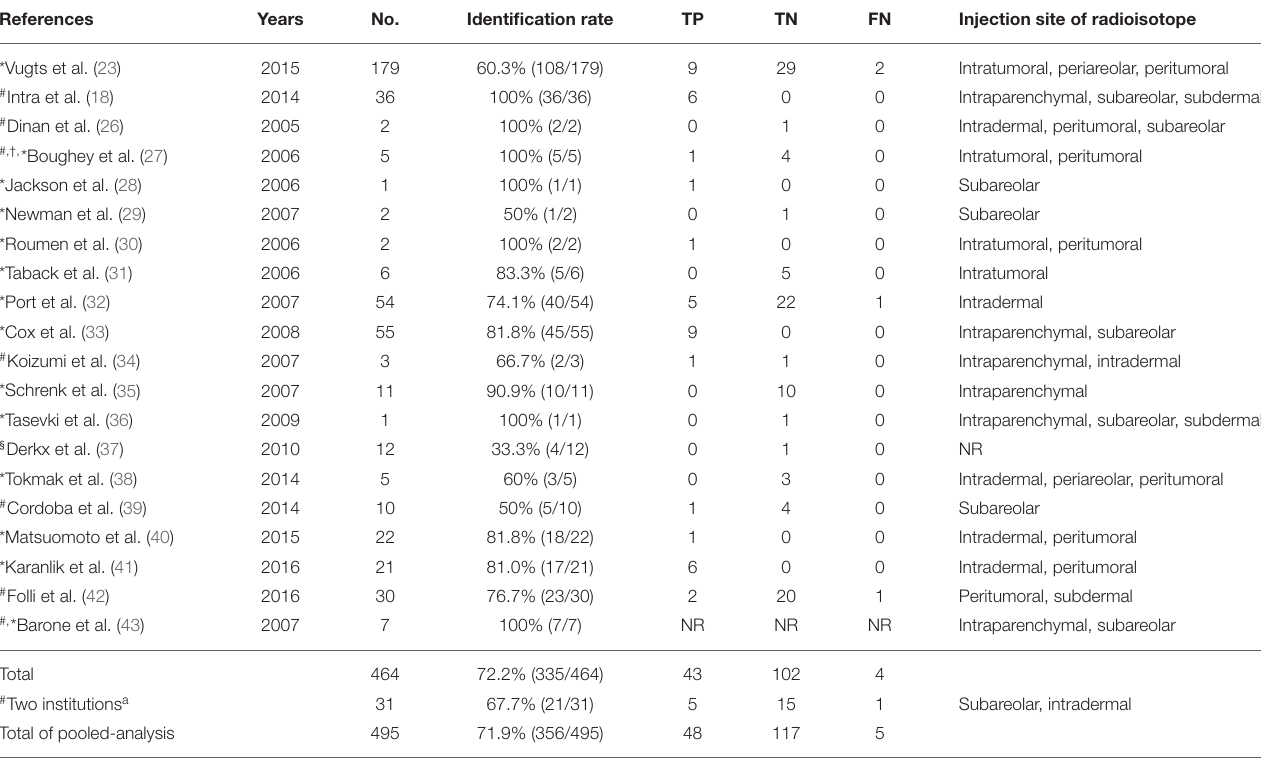
TABLE 1 | Information of publication year, number of patients, identification rate and pathologic status for 20 studies on repeat sentinel lymph node biopsy